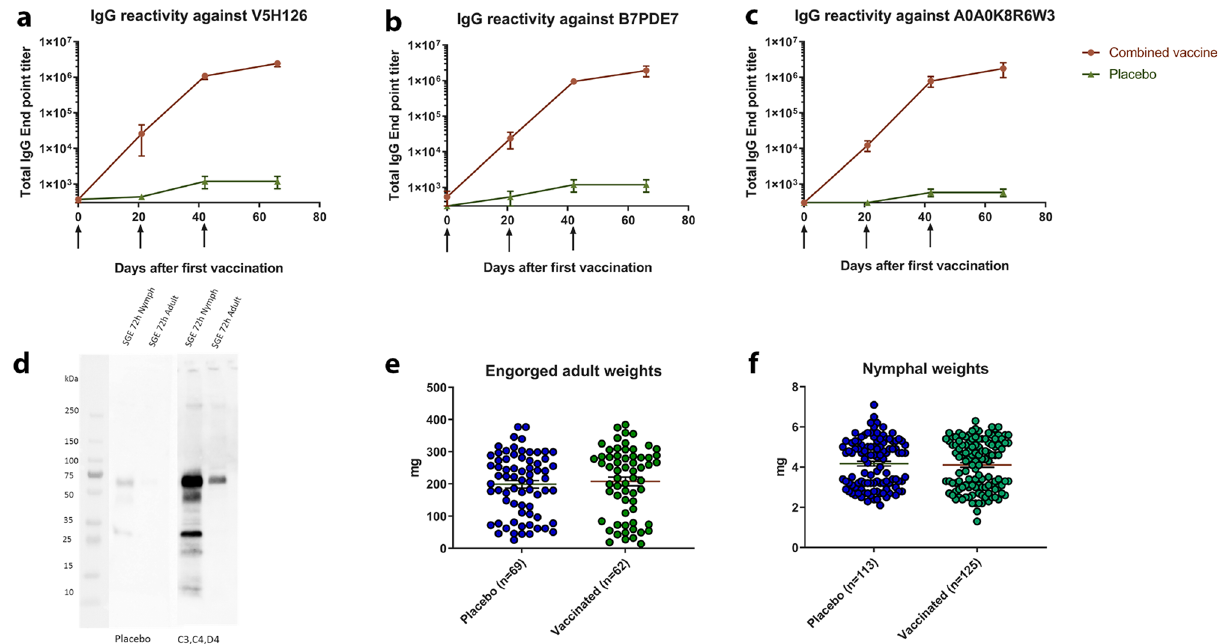
Figure 5. Antibody titers, reactivity and tick feeding parameters after vaccination in rabbits. Antigen specific total IgG endpoint titers as measured by ELISA for V5H126 ( a ), B7PDE7 ( b ) and A0A0K8R6W3 ( c ). Blood was drawn before each vaccination (indicated by arrow) and before tick challenge. End point titers were calculated as Bmin = 3*SD. Dots are means and error bars depict Standard Error of the Mean. ( d and e )Tick engorgement weights for nymphs and adults respectively. Total number of collected engorged ticks are indicated in brackets for each experimental group. Lines indicated means and error bars depict Standard Error of the Mean. ( f ) Western blot of 10 µg 72 h fed nymphal and adult salivary gland extract incubated with pooled serum of placebo vaccinated rabbits (left) or V5H126, B7PDE7, A0A0K8R6W3 vaccinated rabbits